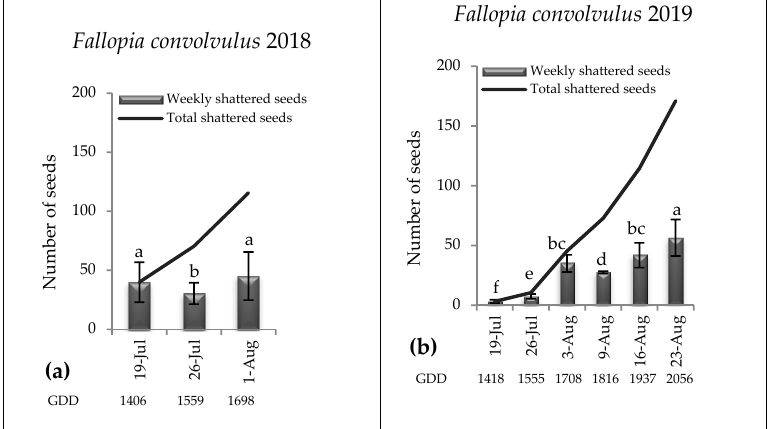
Figure 3. Average weekly and cumulative seed shedding per plant of Fallopia convolvulus in ( a ) 2018 and ( b ) 2019 during the growing season of spring oat. GDD = Growth Degree Days = sum of daily mean temperatures above 0 from the date the oat was sown . Columns with different letters are statistically different at the 0.05 probability level.